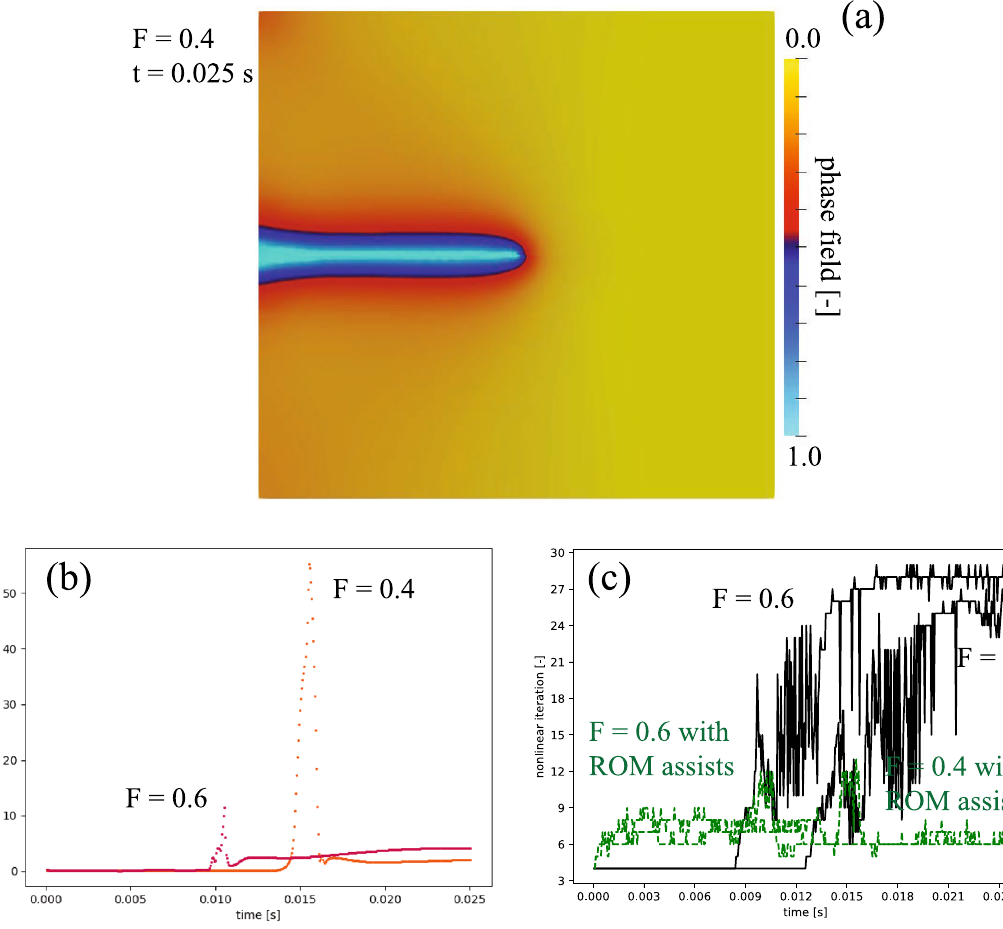
Figure 5. Example 4—results: ( a ) samples of test dataset results of F = 0.4 N at 0.025 s, ( b ) relative error (see Eq. 3) of test dataset results, and ( c ) number of nonlinear iterations for test cases as a function of time with and without ROM assist. Again, the nonlinear solver iteration using default FOM initialization, X h (cid:31) t n − 1 , µ ( i ) (cid:30) as an initial guess for X h (cid:31) t n , µ ( i ) (cid:30) , is shown with a black solid line and using BBT-ROM pressure initialization is shown with a green dashed line. The relative error (see Eq. 3) is calculated between FOM and BBT-ROM for each µ — F as a function of